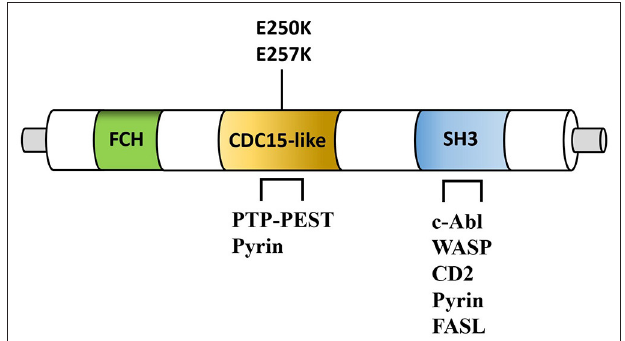
FIGURE 2 | Simplified structure of PSTPIP1 protein. Fes/CIP4 homology domain (FCH), CDC15-like adaptor protein (CDC15-like), SRC Homology 3 Domain (SH3) are shown. Note the position of the PAMI-associated mutations (E250K and E257K). PSTPIP1 interacting proteins include the protein-tyrosine phosphatase (PTP-PEST), pyrin, the Wiskott–Aldrich syndrome protein (WASP), the c-Abl kinase, CD2, and the Fas ligand (FASL). PSTPIP1, proline-serine-threonine phosphatase-interacting protein